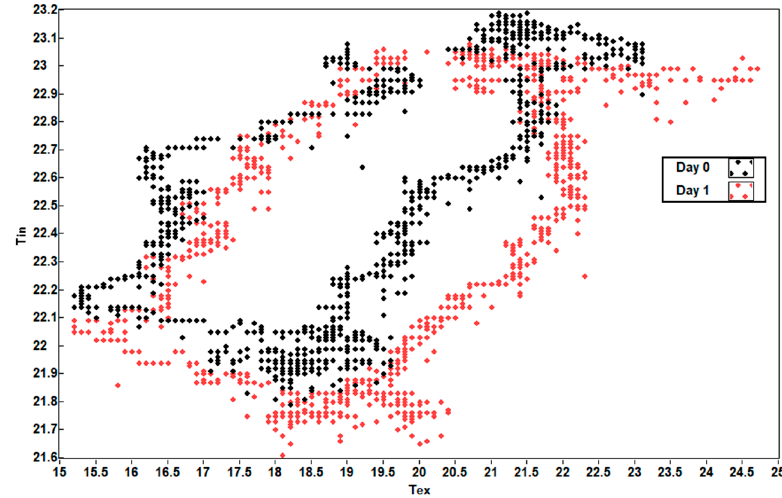
Figure 16. Scatter diagram of battery temperatures T ex and T in .